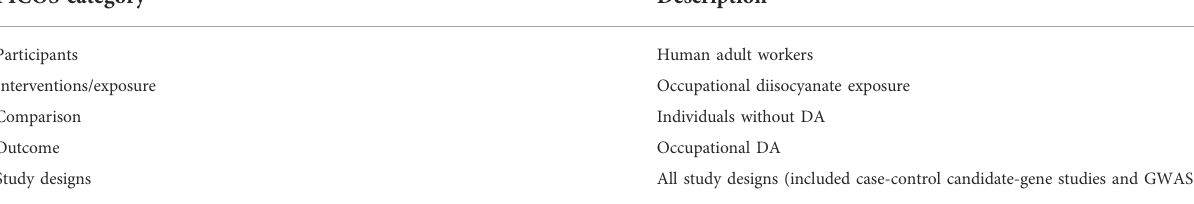
TABLE 1 The Preferred Reporting Items for Systematic reviews and Meta-Analyses (PRISMA) recommended description of the participants, interventions, comparisons, outcomes, and study design (PICOS) targeted in this systematic review. PICOS